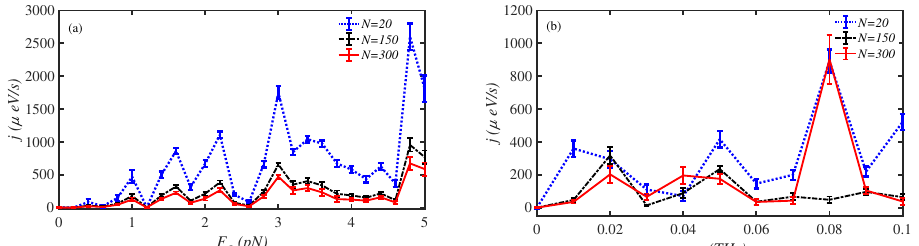
Figure 6. The energy transport rate, j , along protein chains of different length, subjected to external mechanical load at T = 300 K, ( a ) with respect to the magnitude of the force F 0 at fixed frequency ω = 0.1 THz, ( b ) with respect to the force frequency ω at fixed magnitude F 0 = 2 pN.